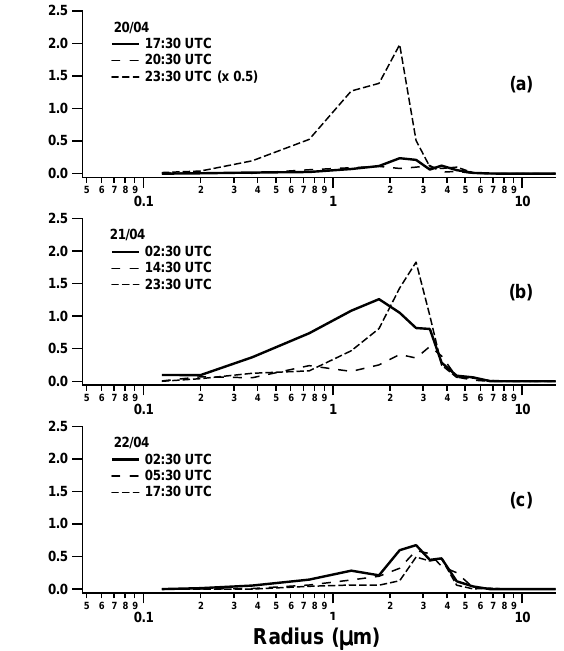
Figura 11 (M. R. Perrone et al.) Fig. 11. Columnar mass size distribution of volcanic ash from FLEXPART simulations at different hours on (a) 20, (b) 21, and